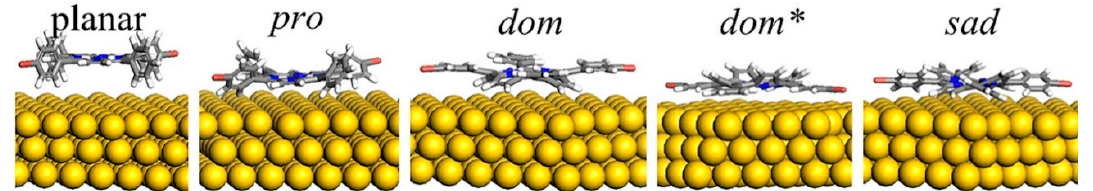
Figure 6. Typical confirmations of meso-substituted tetraphenyl porphyrins on a surface. Reprinted with permission from reference [74] Copyright 2017 American Chemical Society.